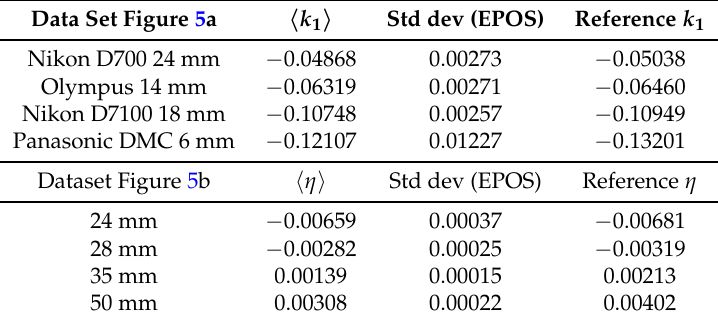
20, except for 50 mm over the data, for which # images ≥